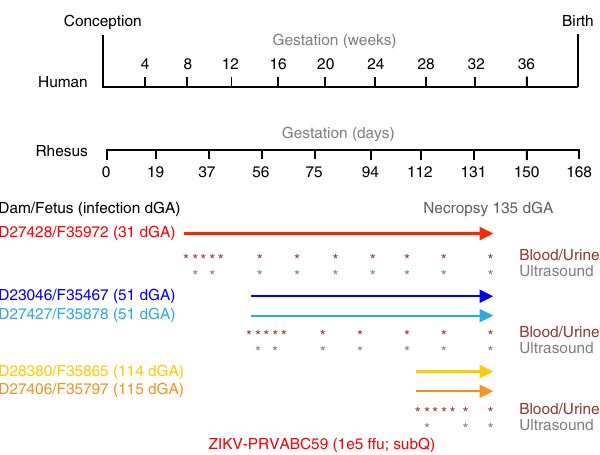
Fig. 1 Experimental design and ZIKV infection relative to fetal brain development. The pregnant dams were infected with ZIKV at 31, 51, 114, and 115 dGA. For all animals, C-section delivery was performed at 135dGA and maternal and fetal tissues were collected. Maternal peripheral blood, urine, and saliva samples (red asterisks) were obtained at the times indicated. Ultrasound analyses of the fetus and placenta were performed at the times indicated with gray